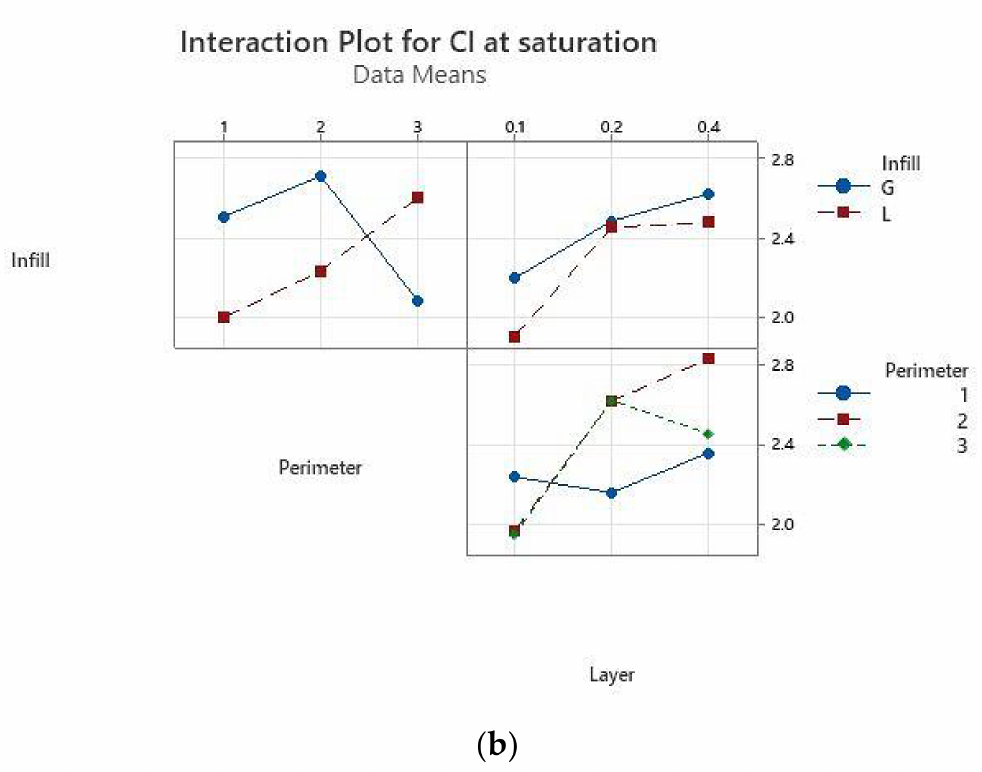
Figure 6. Interaction plots for the absorption rate: ( a ) after 30 min of immersion, ( b ) at saturation. The stress–strain curves for the specimens tested in Experiment 2 are almost coincident when comparing the disinfected and control samples for each parameters combination (best sealing and least sealing), which show that the employed disinfectants do not degrade the bulk properties of the material (Figure 8). Young modulus shows a slight decrease only for the samples manufactured with the best sealing properties: 2013.94 MPa (T_1_01_L control) vs. 1961.88 MPa (T_1_01_L disinfected), 1439.89 MPa (T_2_04_G disinfected)